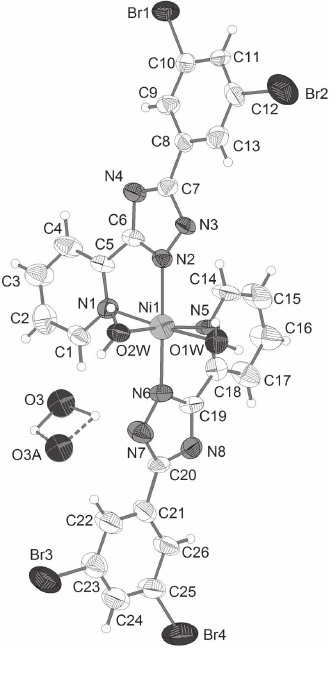
Table 1: Data collection and handling.